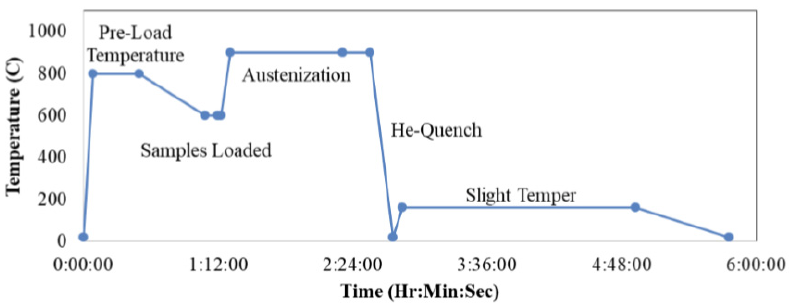
Figure 3. Sintering cycle for PM steel alloy.